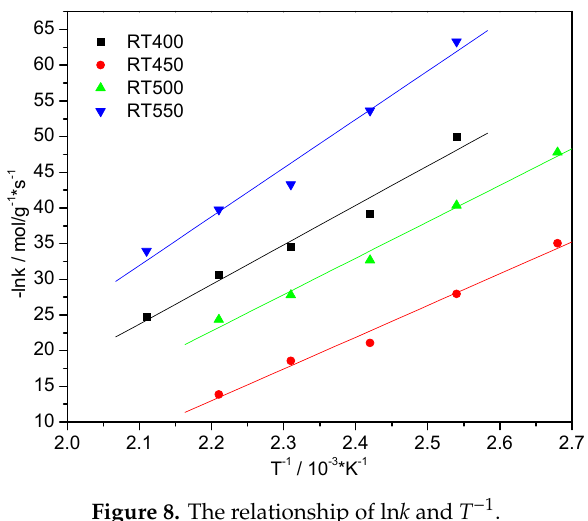
Figure 8. The relationship of ln k and T − 1 . Table 2. Activation energy studies of RTx catalysts (x = 400, 450, 500, and 550).